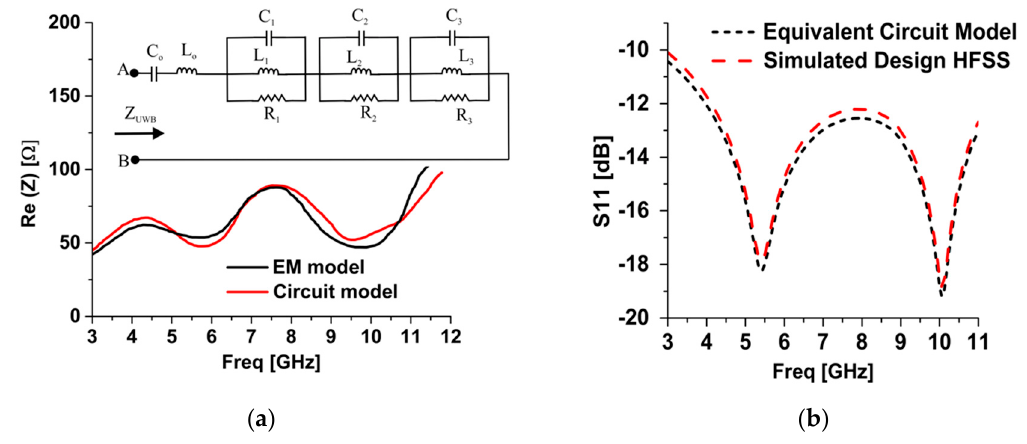
Figure 2. Equivalent circuit: ( a ) real impedance of UWB antenna; ( b ) comparison of reflection coefficients.